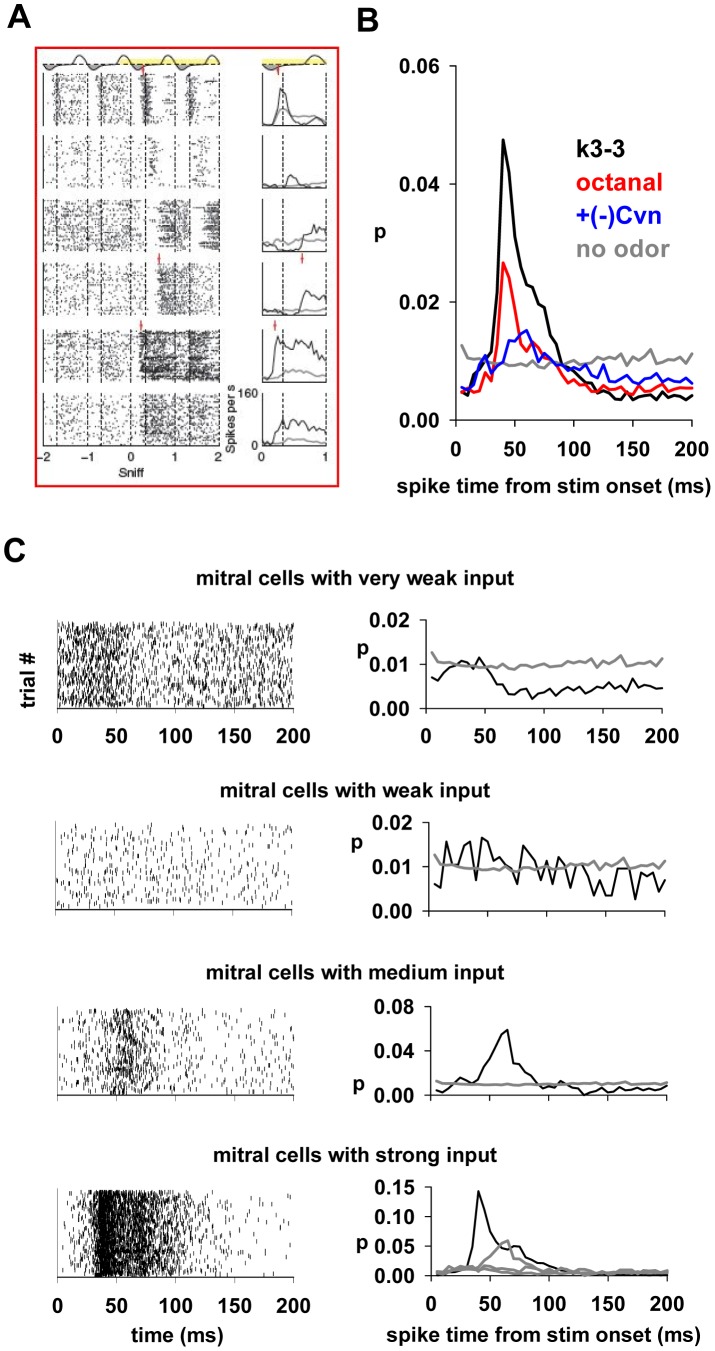
Spike timing of individual mitral cells following odor onset depends on input strength.
A) Experimental findings (from [16], Reprinted by permission from Macmillan Publishers Ltd: Nat. Neurosci.) on the spike times of 6 mitral cells during presentation of the same odor, warped to the sniff cycle (left) and their post stimulus time histograms (PSTH) (right). B) Distribution of spike times from the stimulus onset in our model for octanal (strong odor, red), k3-3 (strong and distributed, black) and +(−)Cvn (weak, blue); light grey line represents the distribution of spike times from background activity. C) (left) raster plots of spike times from 70 simulated sniffs for mitral cells activated by odor k3-3, grouped according to the 4 input levels coding odor strength in the different glomeruli (see Fig. 2); (right) corresponding distribution of spike times from the stimulus onset. The gray line in the top three graphs represents the “no odor” condition; to aid in comparing the distribution of mitral cells with strong inputs (bottom graph) with those obtained under other conditions, the distributions for “no odor”, medium, and weak inputs are indicated by gray lines.